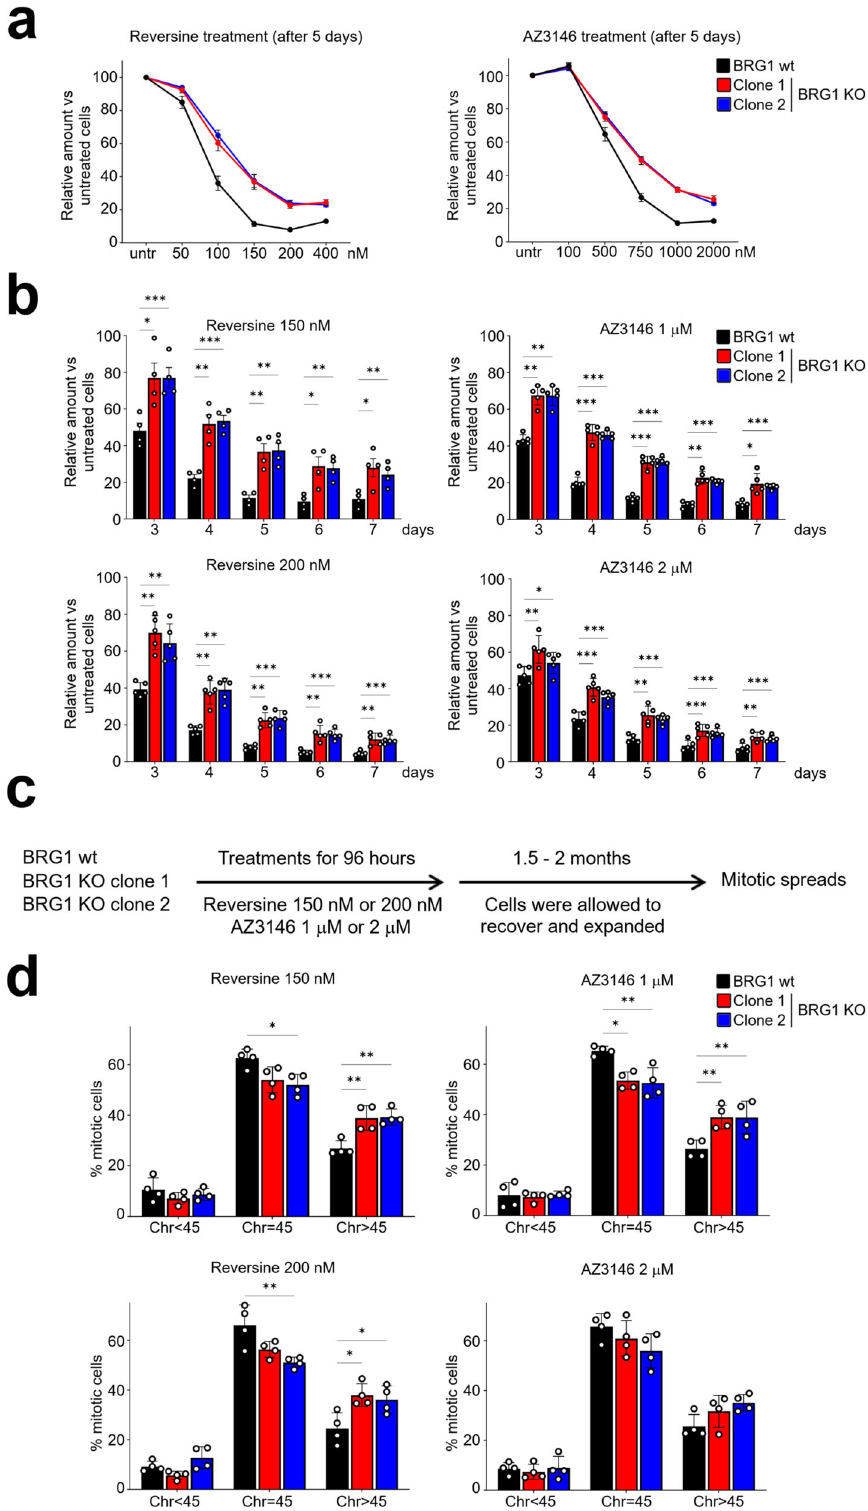
were consistent with a model in which the early changes in aneuploidy-tolerance pathways allow the BRG1 knockout cells to explore different karyotypes without a fi tness penalty. When a karyotypic change occurs that gives the cells a fi tness advantage, this is selected for in the population. It is possible that this accounts for the aneuploidy present in the Baf180 knockout mouse ES cell line 10